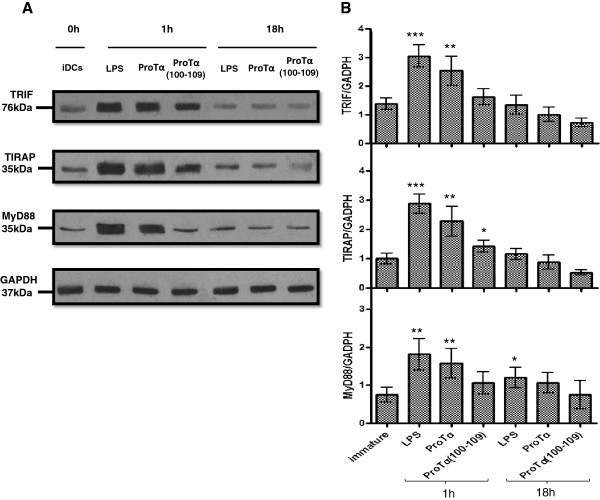
Increased TLR-4-associated adaptor molecule expression in human DCs matured with proTα or proTα(100–109). (A) Representative immunoblots of TRIF, TIRAP and MyD88 expression in cell extracts of iDCs and DCs matured with LPS, proTα or proTα(100–109) for 1 h and 18 h. GAPDH was used to verify equal loading. (B) Densitometry analysis of the adaptor proteins TRIF, TIRAP and MyD88, expressed as relative (%) expression versus GAPDH. Mean values of 4 independent experiments ± SD are shown. * p < 0.05; ** p < 0.01; *** p < 0.001.